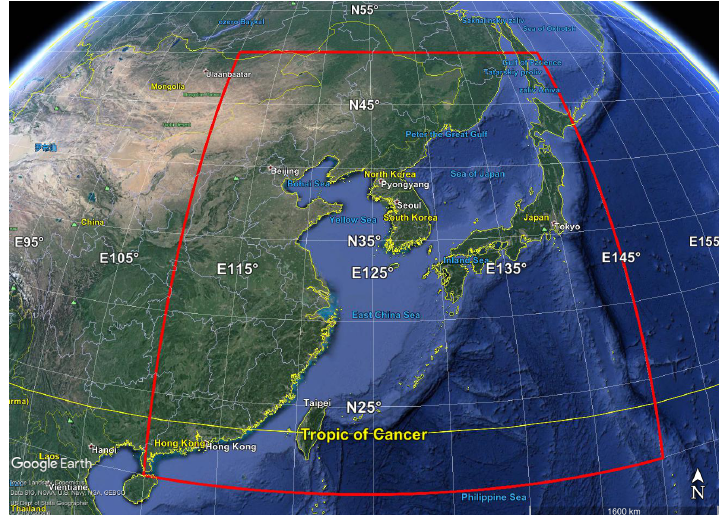
Figure 4. IASI target area over China (red rectangle) used to check the retrieval algorithms.